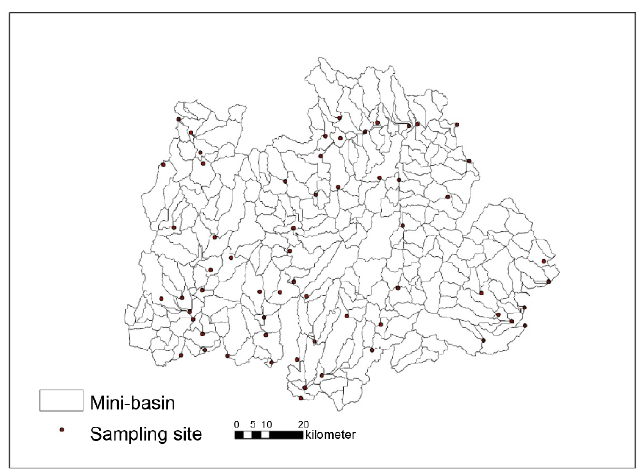
Figure 3. The sixty-one sampling sites selected in this study.